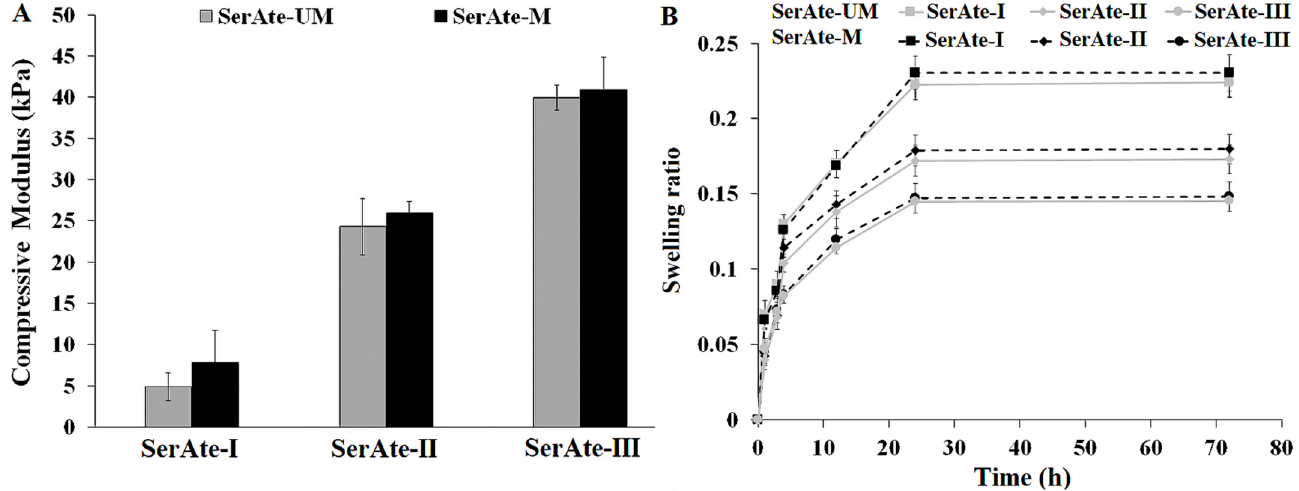
Figure 5. Effect of degree of modification on compressive modulus ( A ) and swelling ratio in PBS ( B ) of SerAte-UM and SerAte-M hydrogels (15 wt% SerAte) at ambient conditions. SerAte-I, SerAte-II, and SerAte-III correspond to SerAte hydrogels with 24%, 31%, and 40% degree of modification, respectively. The values are expressed as means ± SD for n = 3.